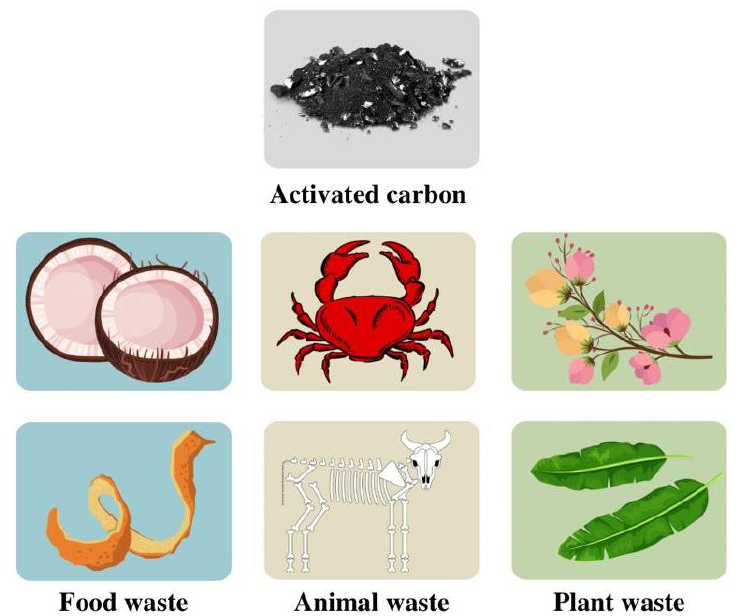
Figure 2. The types of biowaste-derived activated carbon.